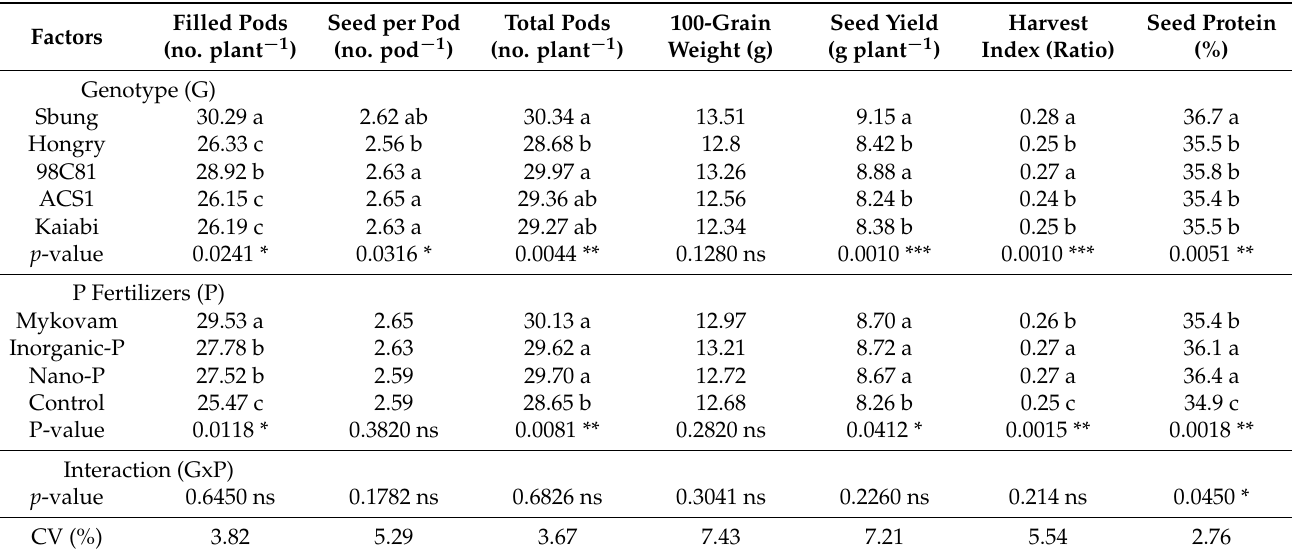
Table 10. Number of filled pods, total of pods per plant, seeds per pod, 100-grain weight, seed yield, harvest index, and seed protein, as affected by genotypes and P fertilizer